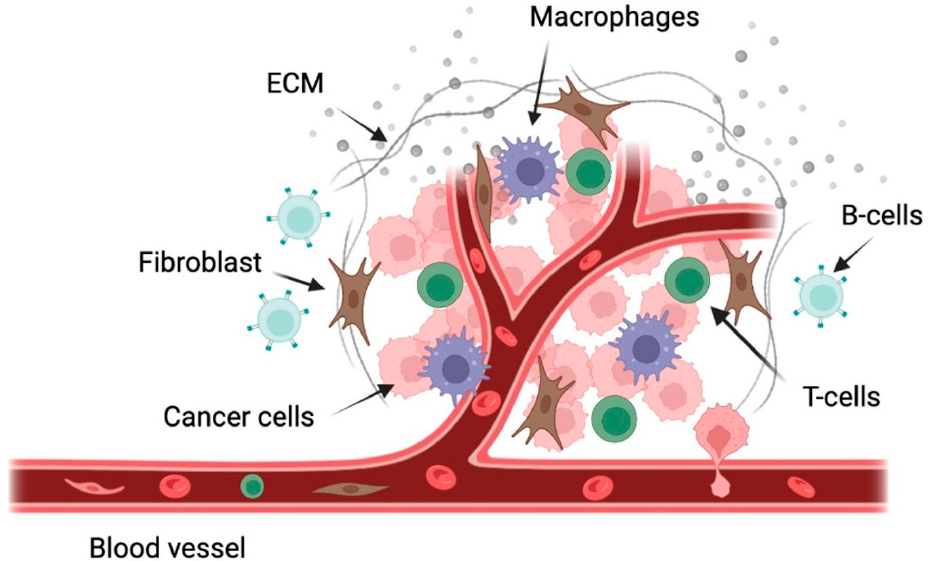
Figure 1. Schematic representation of some of the cells present in the WM tumor microenvironment. This figure was generated using biorender.com .